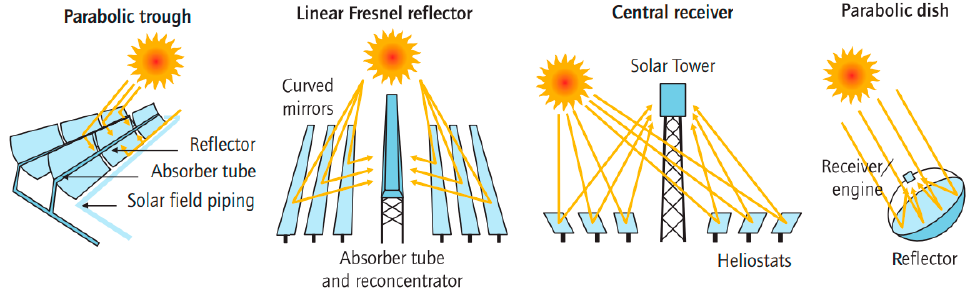
Figure 1. Concentrating geometries of the main solar power technologies in this review. Adapted with permission [1]; 2019, Elsevier.